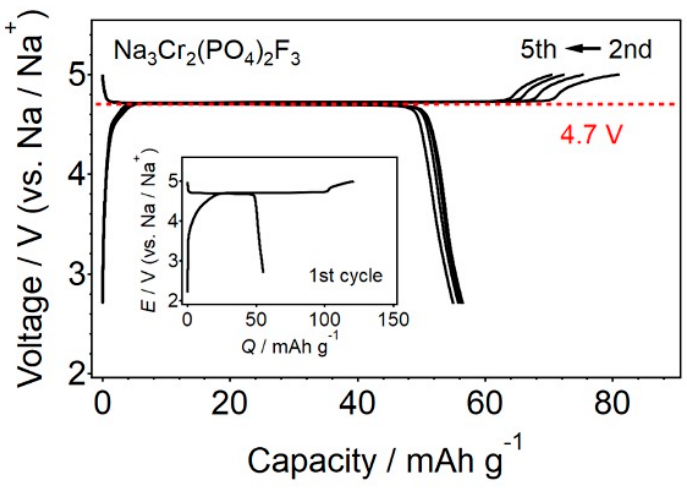
Figure 5. Galvanostatic charge–discharge curves of Na 3 Cr 2 (PO 4 ) 2 F 3 electrode in Na half-cell at a rate of 0.1 C between 2.7 and 5.0 V vs. Na/Na + (1 C = 63.8 mA g − 1 ). Inset shows the first cycle.